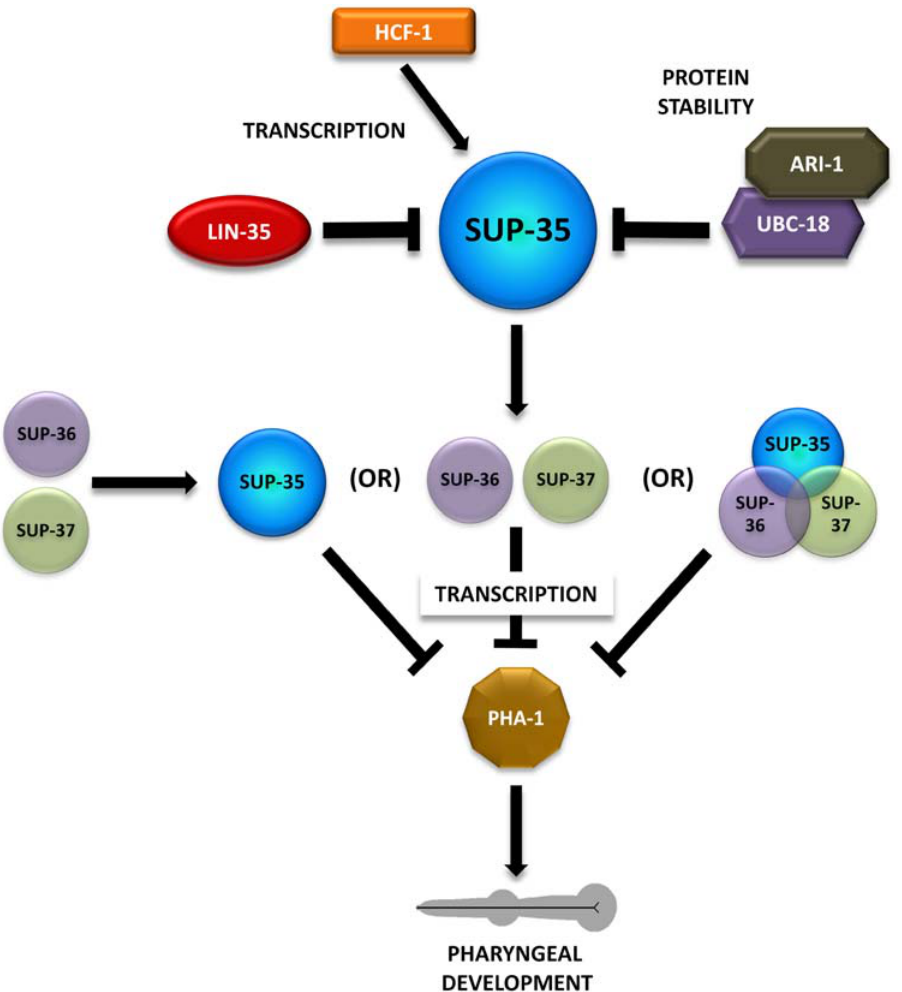
Figure 9. Model for the regulation of PHA-1. Schematic of the regulatory circuit acting upstream of PHA-1. We note that regulation of SUP-35 by LIN-35, HCF-1, and UBC-18–ARI-1 may not be direct, but could involve intermediate steps. For additional details, see